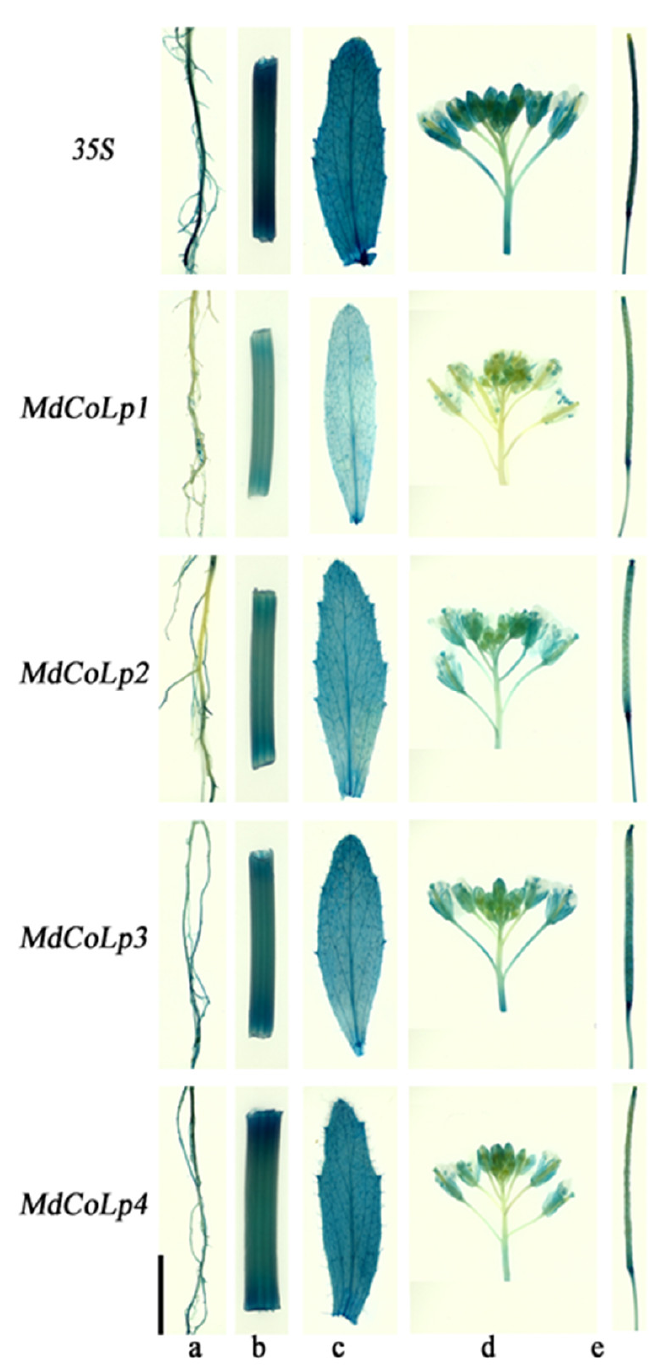
Figure 5. Histochemical staining of GUS in roots ( a ), stems ( b ), cauline leaves ( c ), inflorescences ( d ) and siliques ( e ) of Arabidopsis transformed with the construct of MdCoLp1/2/3/4::GUS and 35S::GUS at 35 days of seedlings Scale bar is 2 mm.